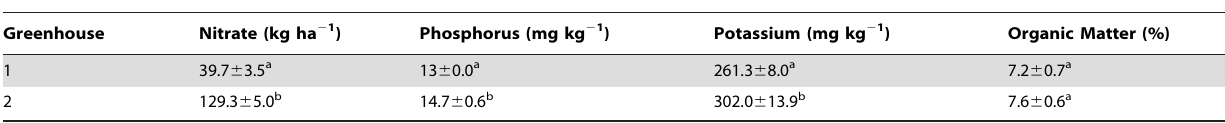
Table 1. Soil nutrient